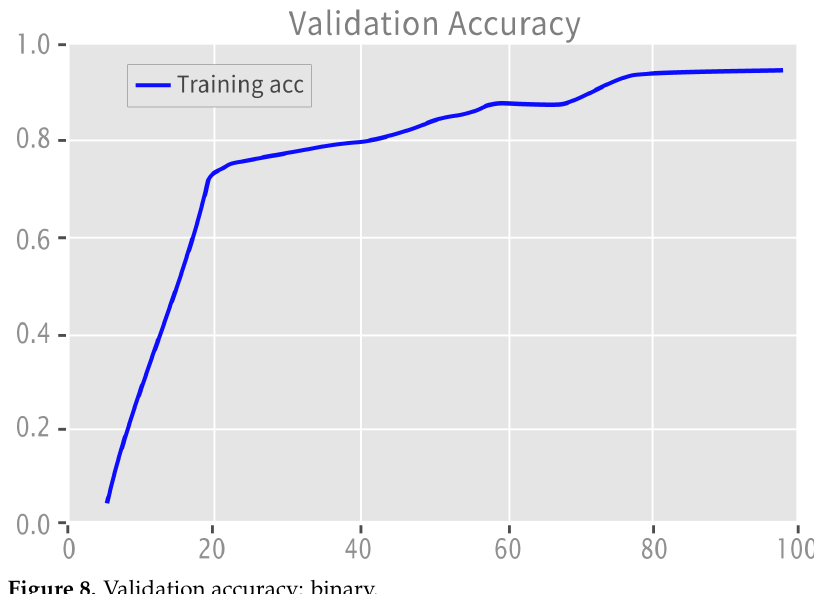
Figure 8. Validation accuracy: binary.